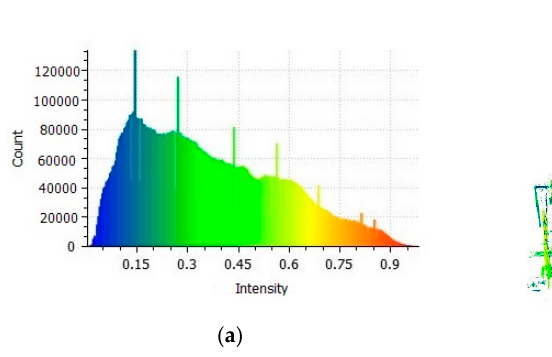
Figure 16. A number of the magnified segregated patches. Employing Inequality ( 5 ), window detection is carried out with 15 steps for the partitioning process. Therefore, patches with consecutive big leaps on the diagrams (Figure 17) or with big differences between the maximum and the minimum are identified as windows. To evaluate the window detection approach, their bounding boxes are determined on the original point clouds as the ground truth. We prefer to perform a pessimistic assessment while considering the ability of the proposed approach in large-scale window detection. Therefore, if at least 70% of points of a detected patch are located inside one of the reference bounding boxes, the patch is considered TP. If less than 50% of points of a detected patch are placed inside a reference bounding box or it has no correspondence in the ground truth, the patch is counted as FP. If a bounding box does not contain at least 50% of points of one of the detected patches or it has no correspondence among the patches, then it is considered as FN. The evaluation results of both datasets are presented in Table 2. In Figure 18 the results of the method are displayed. The extracted patches inside the bounding boxes illustrate the outcome.